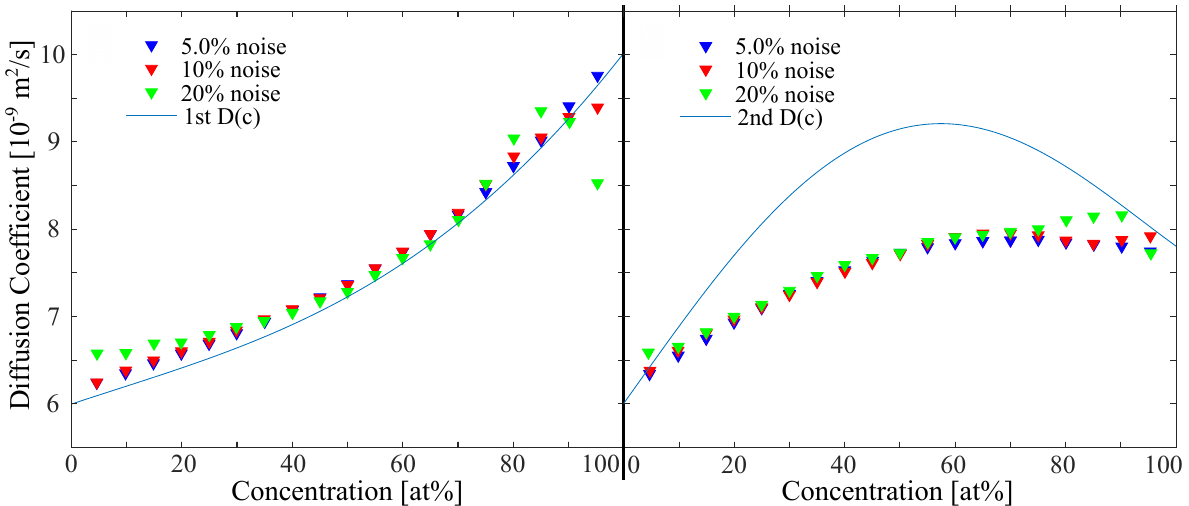
Figure 3. Effect of noise on the Local Erf-fit analyzing approach. Error bars exceed the chosen scale of the graph. They have not been plotted in favor of a clearer layout. The inaccuracy due to the fluctuations in the results of the algorithm is around 5–10%, increasing with noise. However, the systematic error of the evaluation method is greater at least for the 2nd D ( c ) . The algorithm coefficient is chosen to be ∆ x = 25